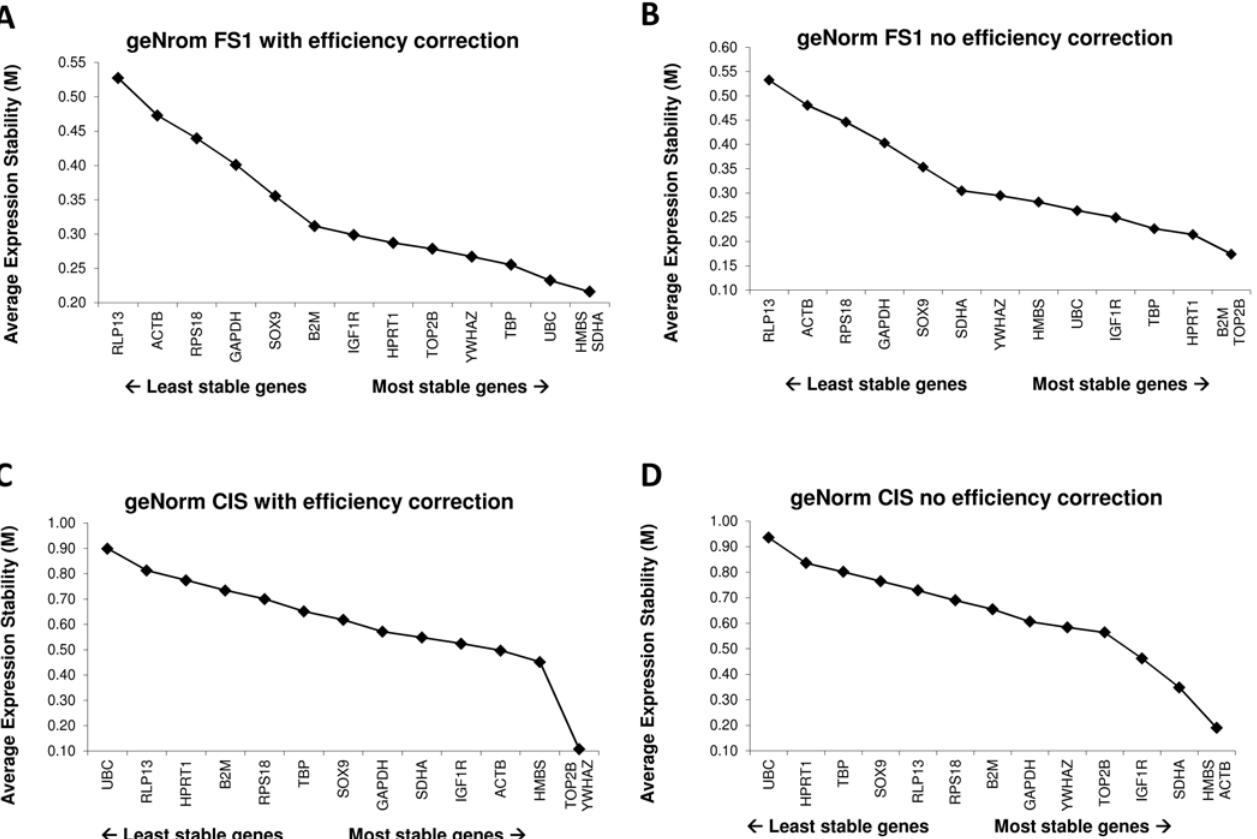
Fig 1. geNorm outputs with efficiency corrected data (A&C) and without efficiency corrected data (B&D) for the two datasets, i.e. FS1 (A&B) and CIS